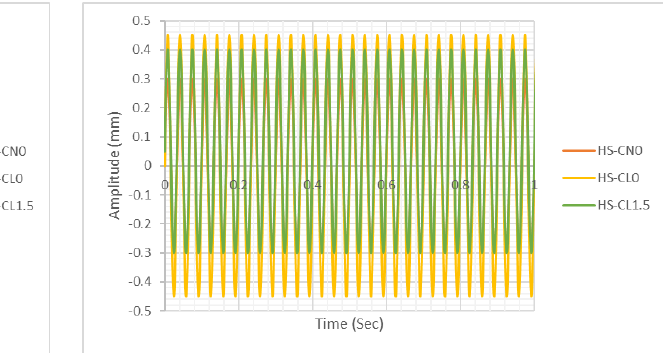
Figure 9: Vibration-time history under harmonic load with 25Hz frequency